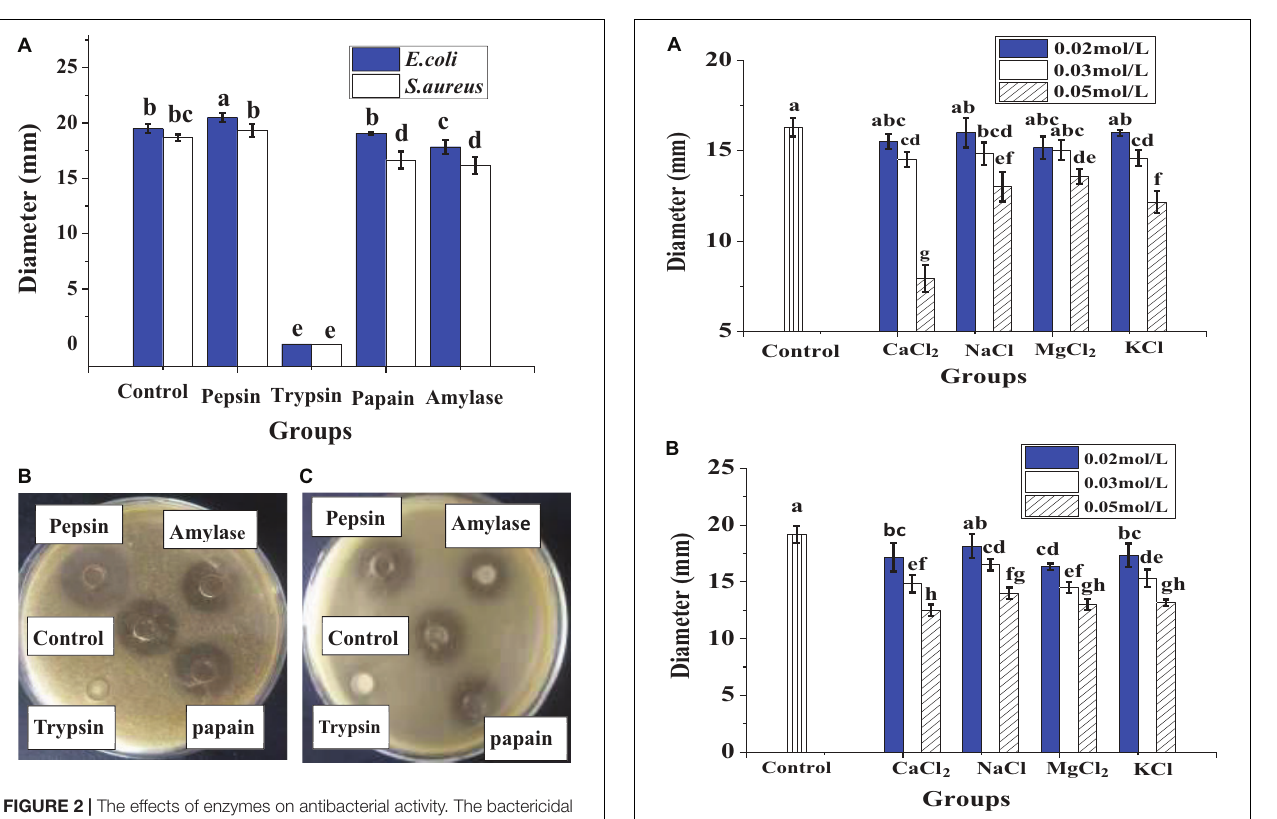
FIGURE 3 | The effects of metal ions on antibacterial activity against E. coli (A) and S. aureus (B) , in which different lowercase letters meant that the antibacterial effect was significantly different ( P < 0.05).